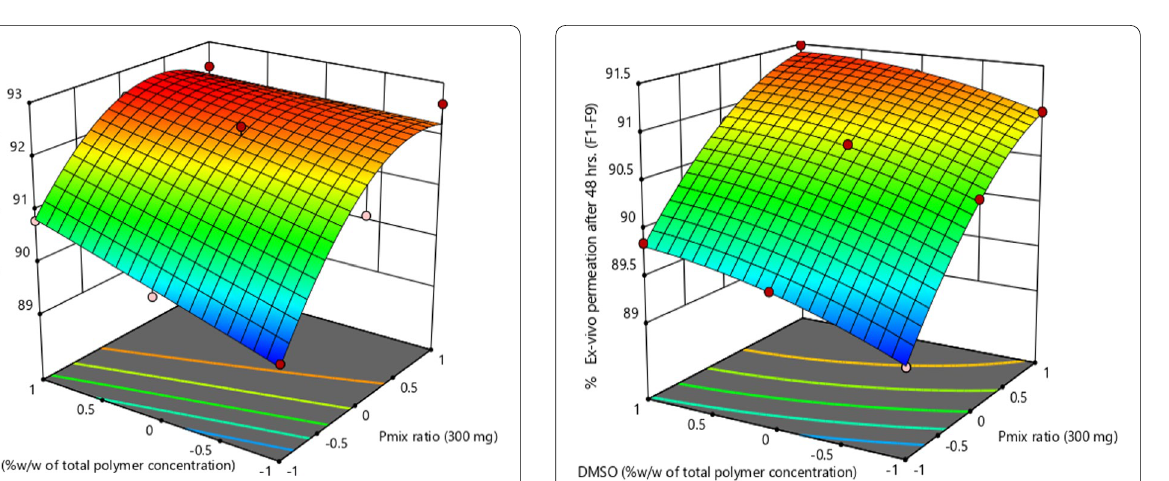
Fig. 6 Response surface plot of % in vitro of transdermal patch